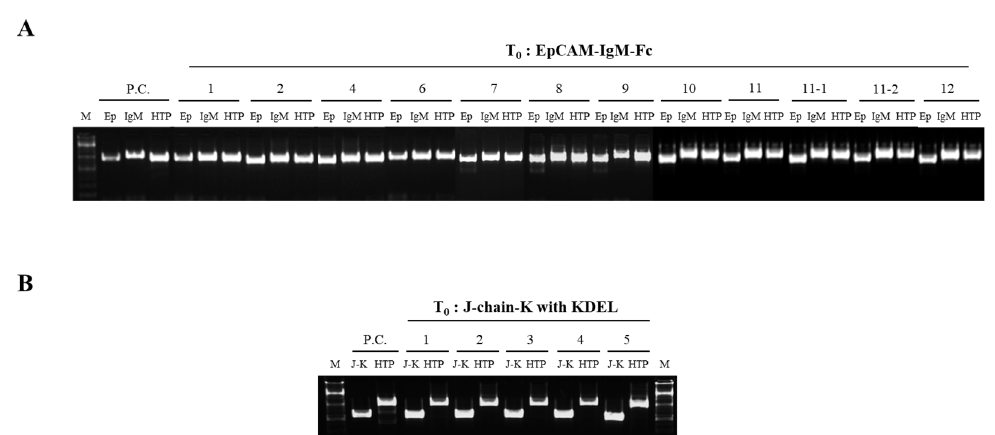
Figure 3. A polymerase chain reaction (PCR) analysis to confirm the transgenes encoding EpCAM–IgM Fc and J-chain K in T 0 transgenic lines. ( A ) Transgenic lines (#1–12) carrying the transgene encoding EpCAM–IgM Fc were tested by PCR using three different primer sets for EP, IgM Fc, and HTP. PC is a